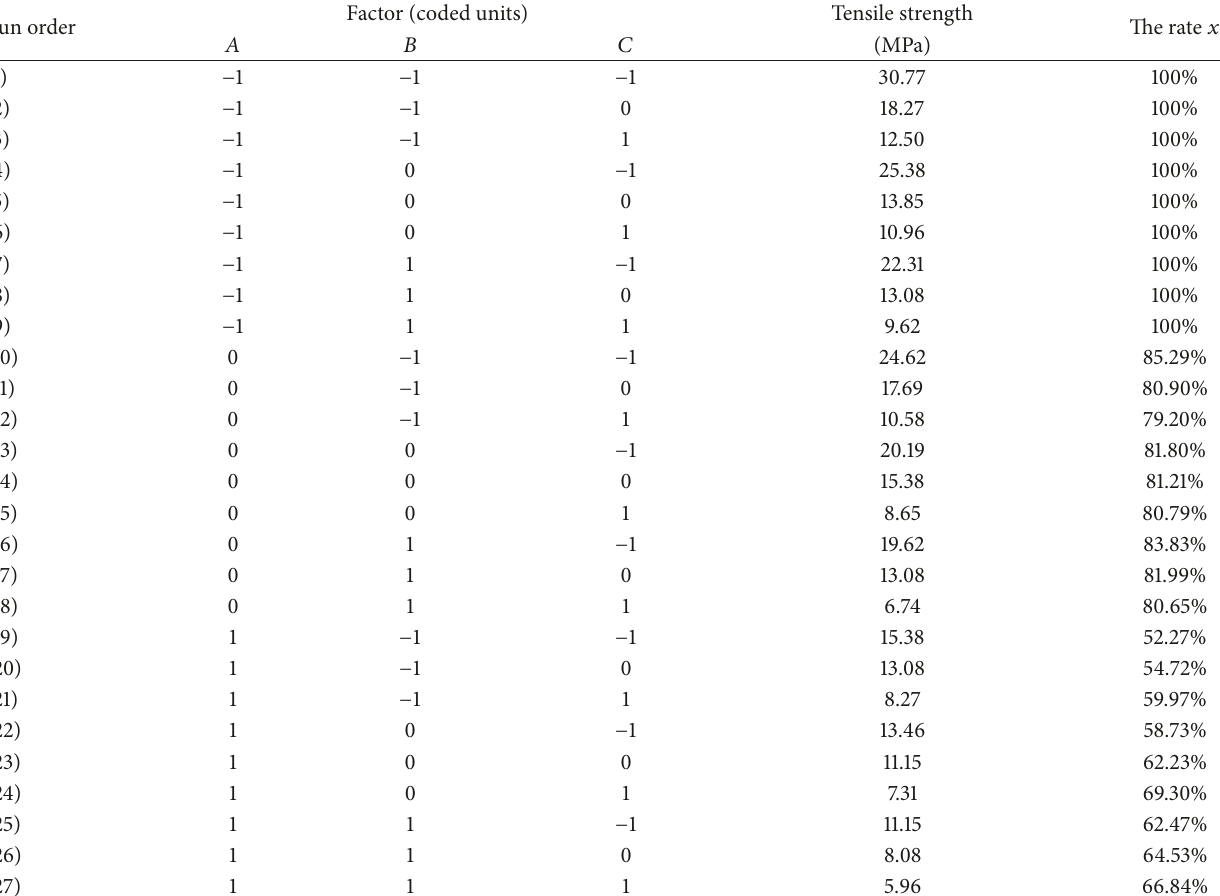
Table 2: The experiment results of tensile strength and bonding degree with various combinations of the parameters under different level values.